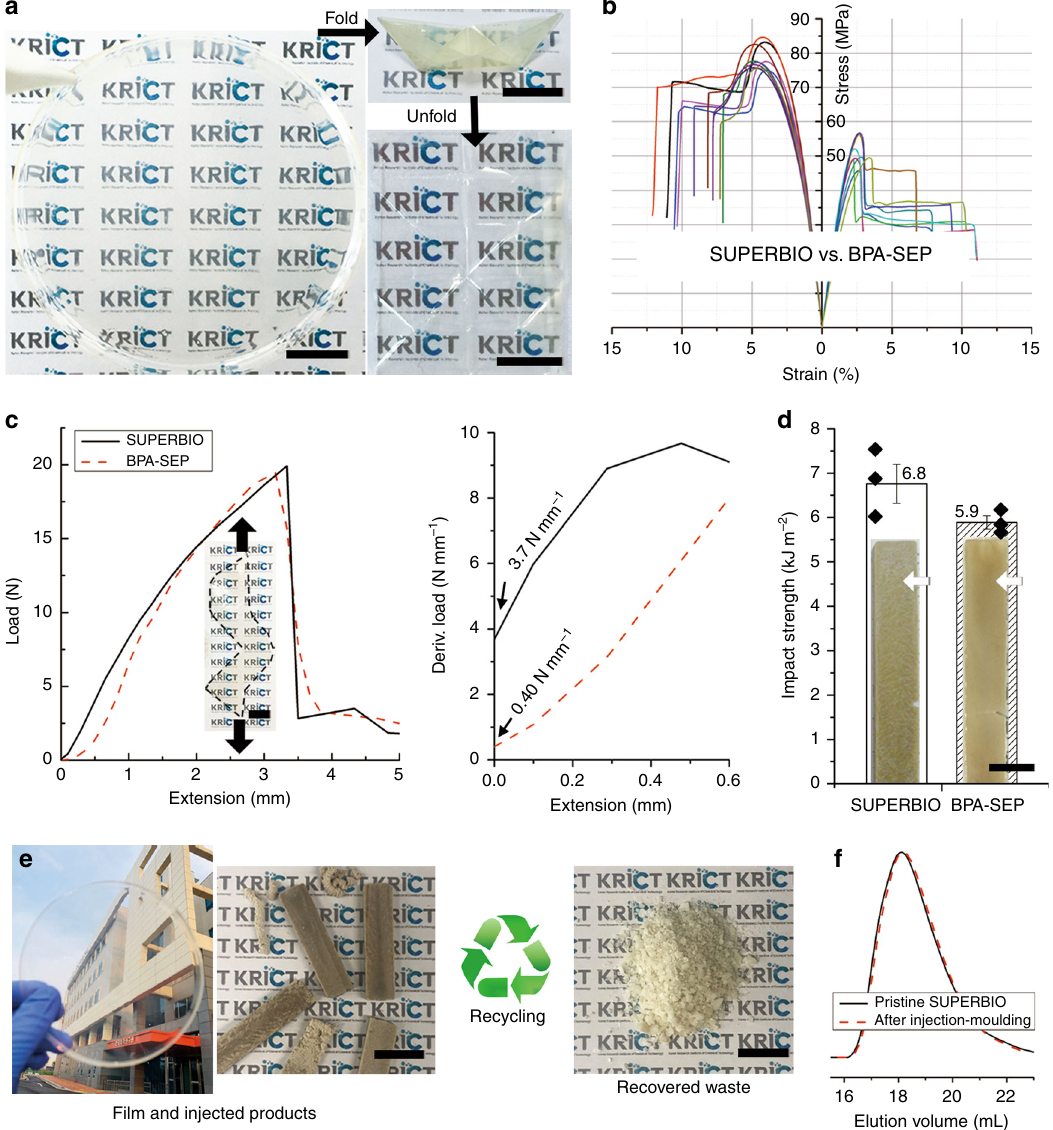
Fig. 2 Damage-tolerant bio-based super engineering plastic. a Photographs of the solution-casted pristine, origami-folded (top), and unfolded (bottom) fi lms of SUPERBIO (scale bar: 1 cm, Supplementary Movie 1). b Tensile stress-strain curves of SUPERBIO ( n = 10) and BPA-SEP ( n = 8) fi lms. c (Left) Original and (right) differential tear load-distance curves of SUPERBIO and BPA-SEP fi lms. Inset is photograph of the specimen for tear test (KS M ISO 34- 1:2014, scale bar: 1 cm). d Impact strength of the injection-moulded SUPERBIO and BPA-SEP. Inset is photograph of the rectangular bar-shaped specimens for the impact test (scale bar: 1 cm). Each impact strength value represents the mean and standard error of triplicate samples. e Recycling of SUPERBIO products (scale bar: 1 cm). f DMF-GPC pro fi les before/after thermal processing. M w s of pristine and injection-moulded SUPERBIO were 92.2, and 89.7 kg mol − 1 ,